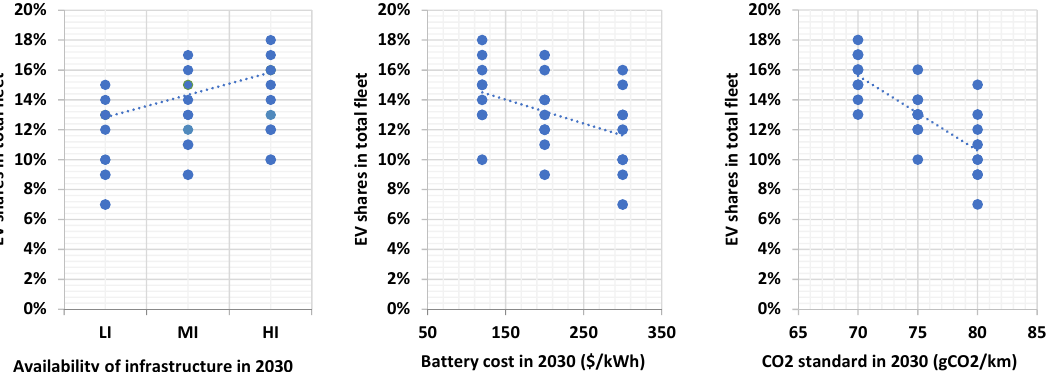
Figure 3. The distribution of the electric vehicle (EV) market shares in the EU in 2030.